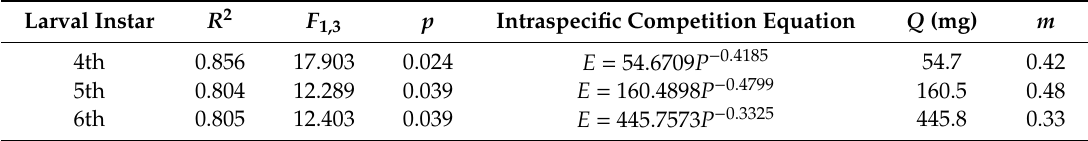
Table 3. Parameter estimates of the intraspecific competition equation (Equation (3)) of consumption by the FAW larvae at various FAW